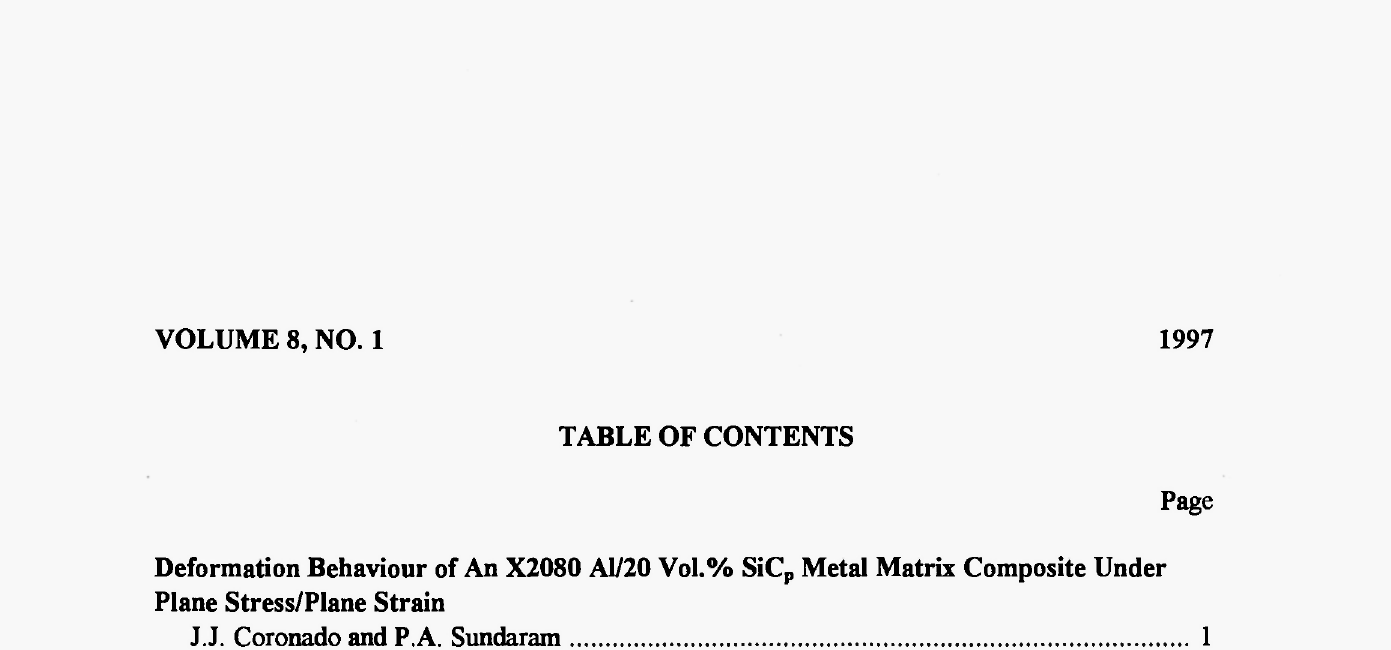
Deformation Behaviour of An X2080 Al/20 Vol.% SiC Plane Stress/Plane